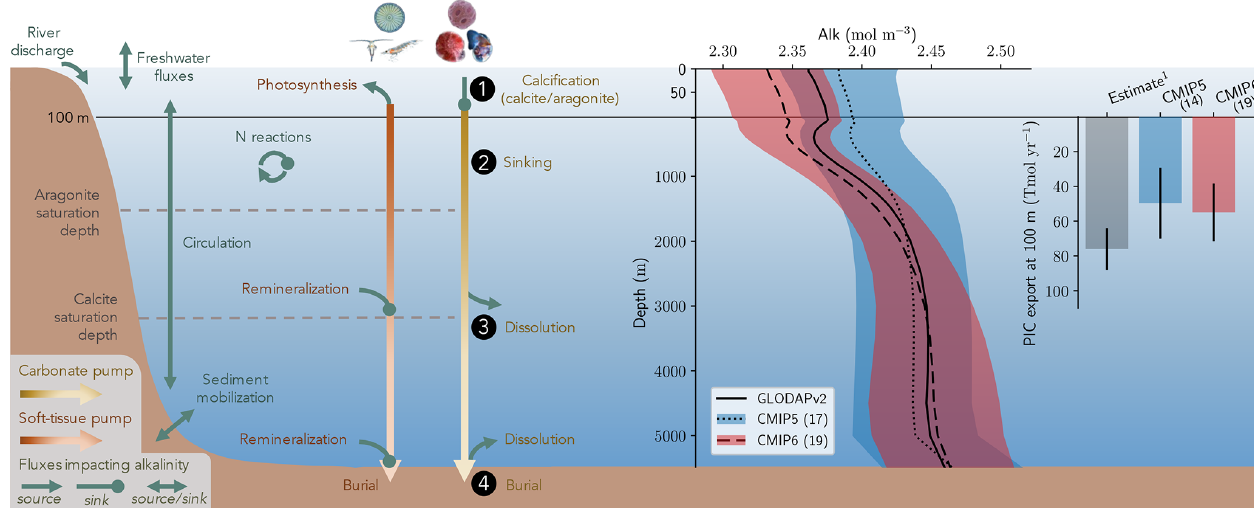
Figure 1. Schematic illustration of the processes affecting alkalinity (Alk) in the ocean highlighting the key steps of the carbonate pump addressed in this study (1, calcification, 2, sinking, 3, dissolution and 4, burial). For the CMIP5 and CMIP6 ensembles, the global-mean Alk profile and a bar chart of the total particulate inorganic carbon (PIC) export at 100m are also presented with their associated standard deviation. Also shown are observations from GLODAPv2 for the Alk profile and the observationally derived estimate of PIC export from Sulpis et al. (2021; 1 assessment at